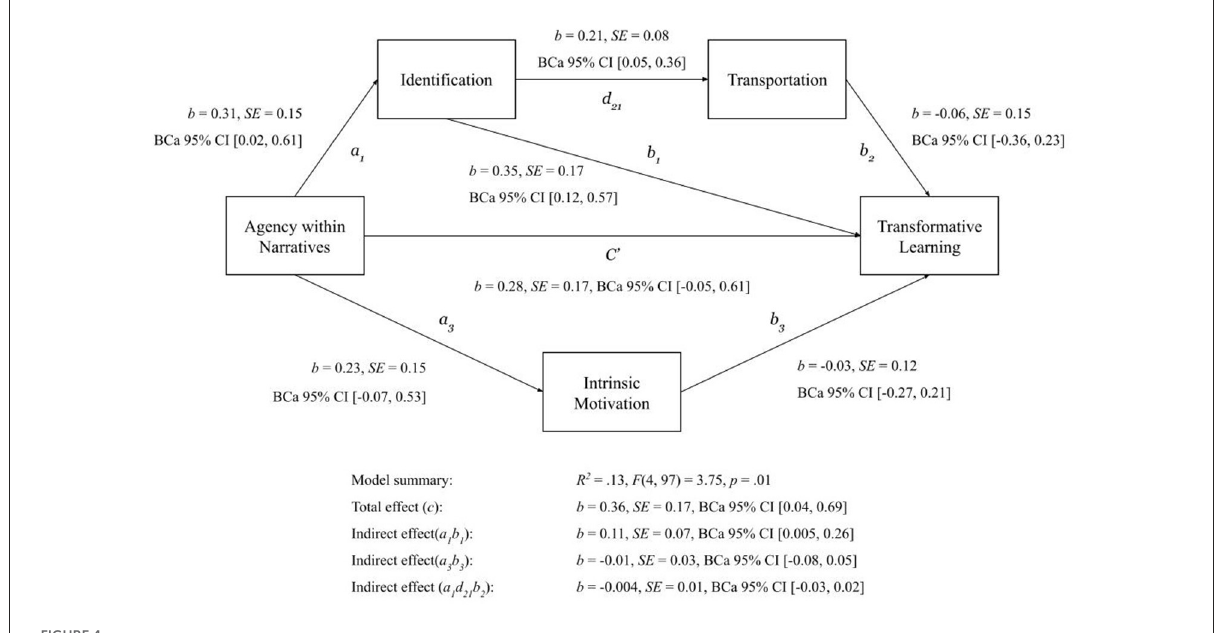
FIGURE4 Mediation analysis experiment 2–transformative